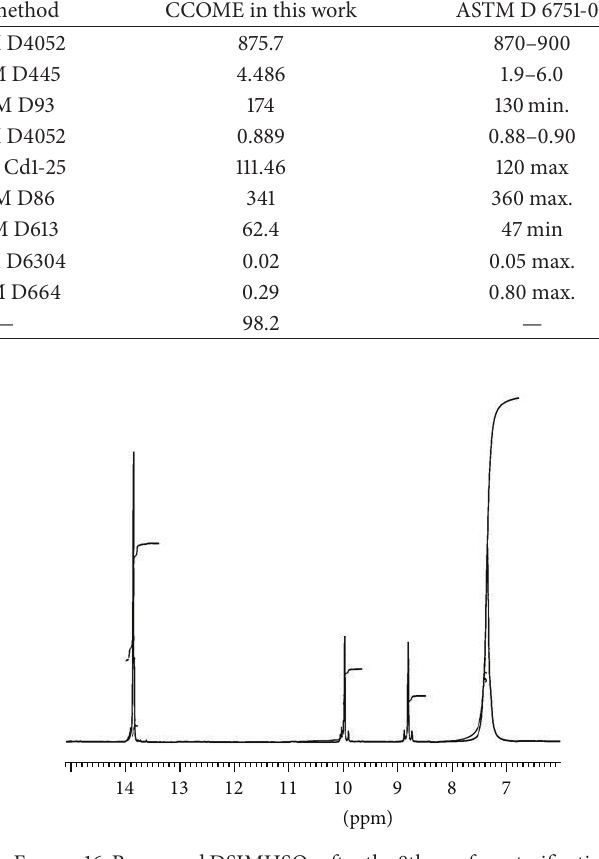
Figure 16: Recovered DSIMHSO 4 after the 8th run for esterification